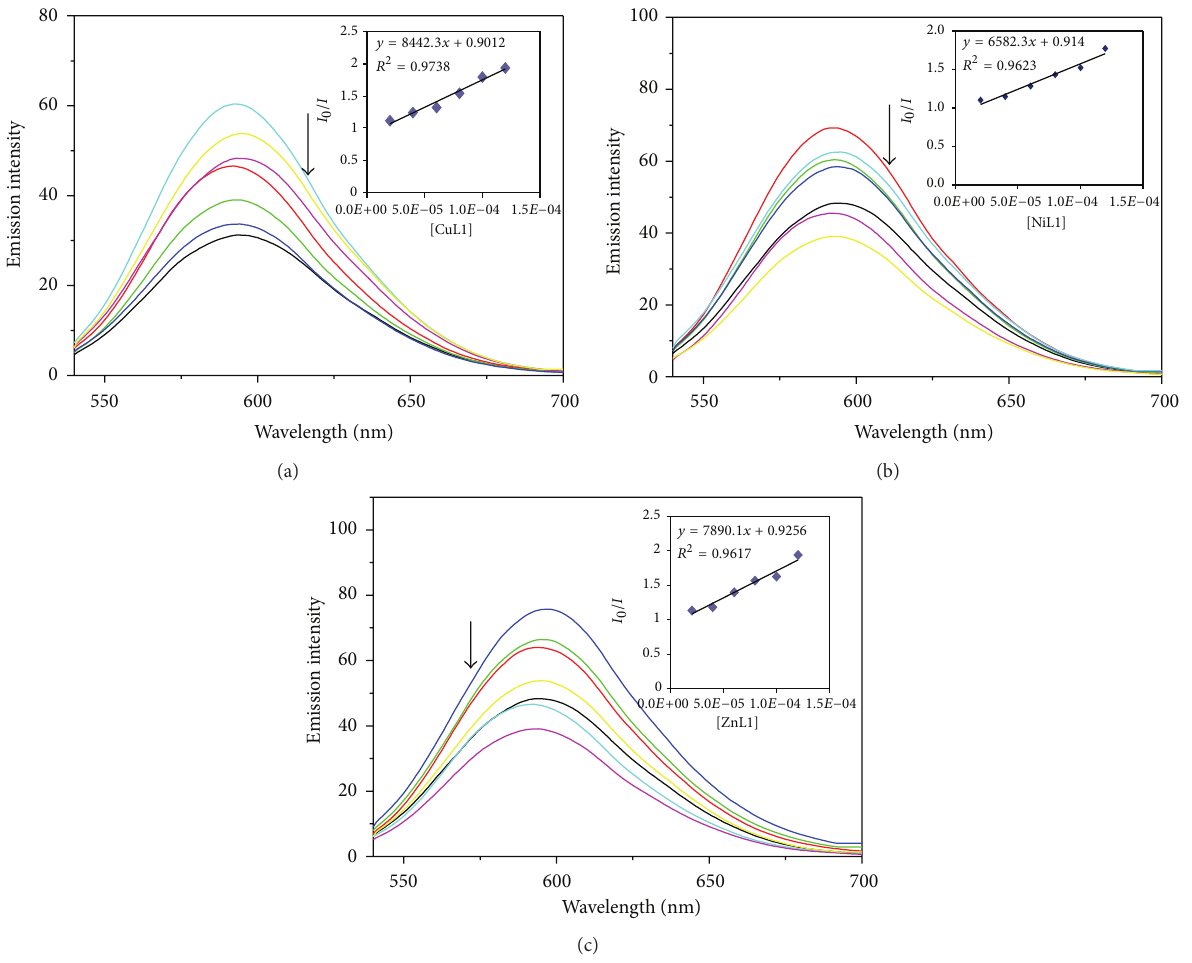
Figure 3: Emission spectra of ethidium-bromide-bound DNA in the presence of (a) CuL, (b) NiL, and (c) ZnL. The arrow shows the intensity change upon increasing complex concentrations. Inset shows the plot of 𝐼 0 /𝐼 Vs [complex].